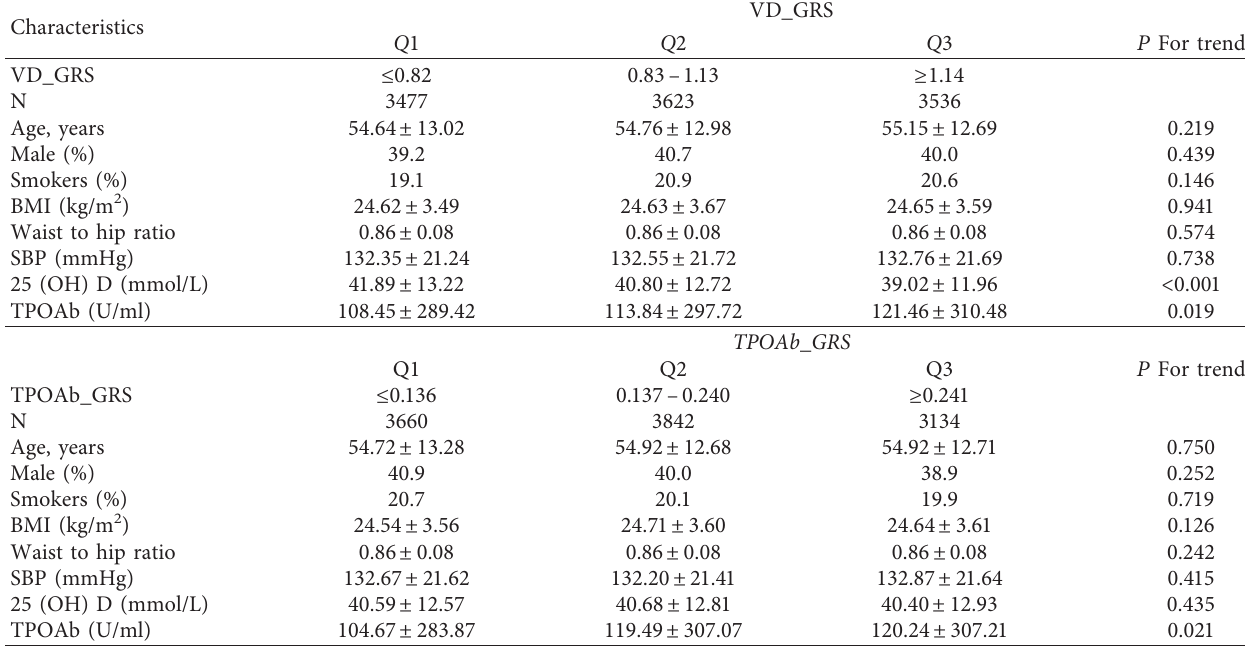
Table 4: Characteristics of study participants according to the weighted vitamin D genetic risk score (VD_GRS) and weighted TPOAb_GRS ( n �